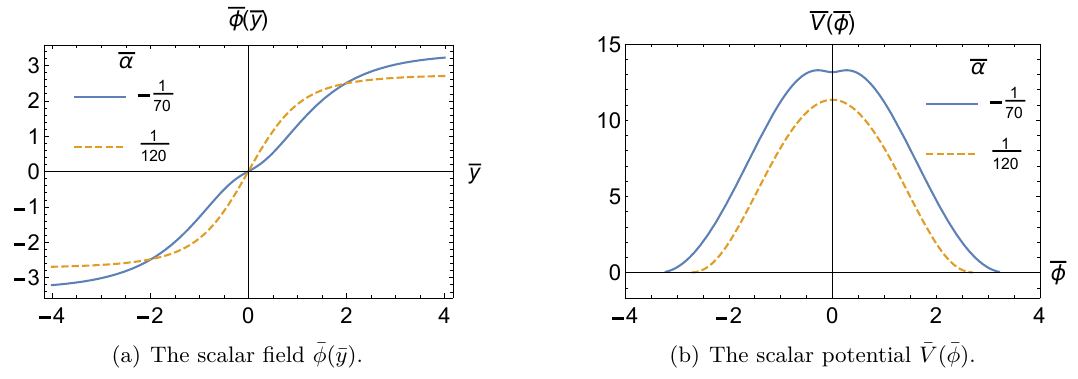
Figure 2 . Plots of the dimensionless scalar field ¯ φ (¯ y ) and the corresponding dimensionless scalar potential ¯ V (¯ φ ) for the brane world solution (5.10). The parameter n is set to 1